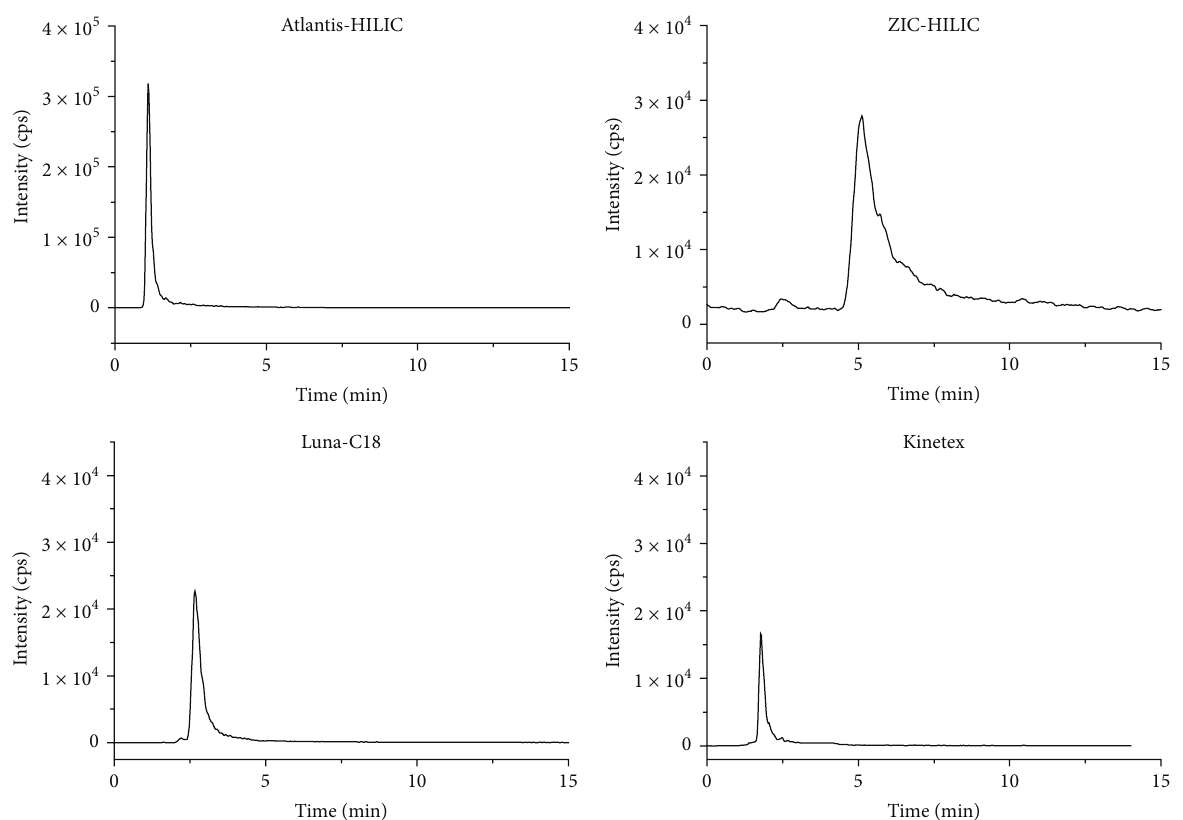
Figure 4: Extracted ion chromatograms of luteolin on HILIC and RP columns under isocratic elution. Eluent for HILIC column-ACN/H 2 O (95/5%, v/v), for Luna-C18 ACN/water (45/55%, v/v), and for C18: ACN/water (20/80%, v/v).